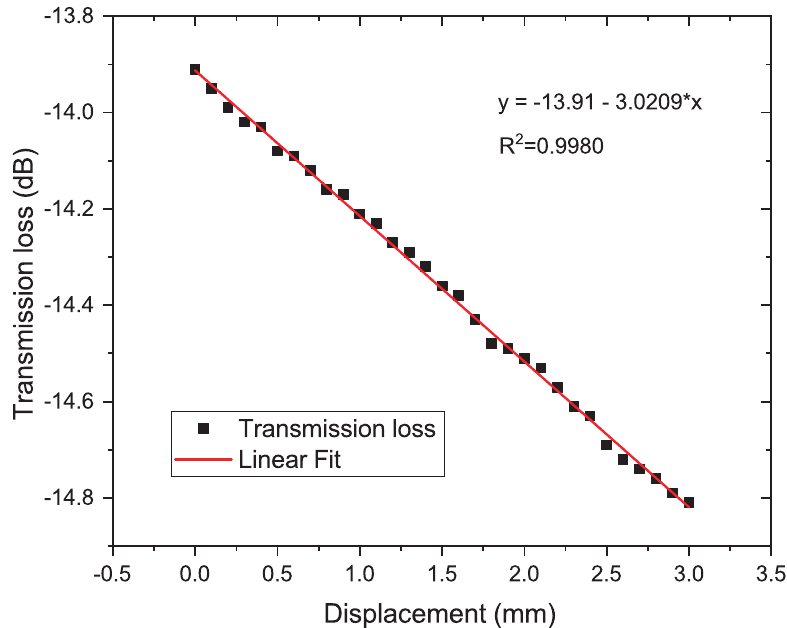
Figure 10. Transmitted intensity of the balloon-shaped interferometer as a function of the 3D piece